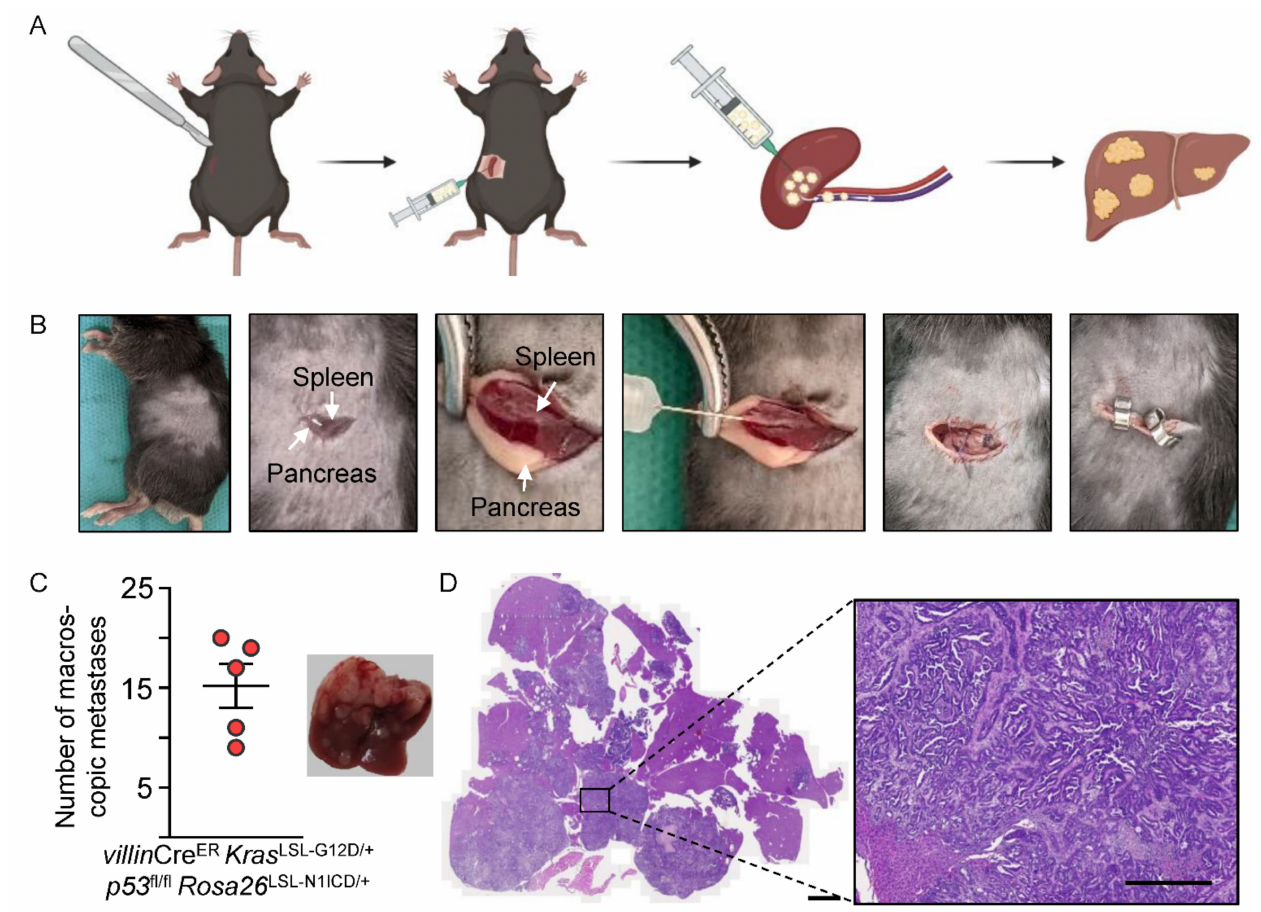
Figure 4. Modeling CRC liver metastasis by intrasplenic injection. ( A ) Illustration of the intrasplenic injection procedure of MDOs. ( B ) Images of the experimental set-up to model liver metastasis. ( C ) Left: quantification of the number of macroscopic KPN liver metastases nodules per mouse ( n = 5). Right: representative image of liver metastases. ( D ) H&E images of KPN liver metastases. Scale bars indicate 2000 µ m (left) and 500 µ m